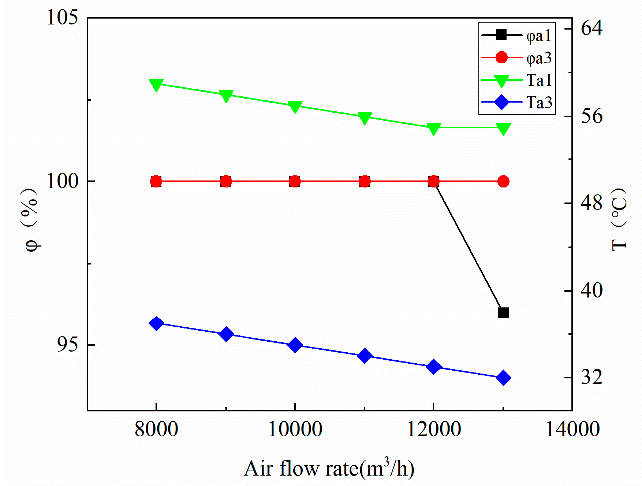
Figure 7. E ff ect of air flow rate on air humidity and air Figure 7. Effect of air flow rate on air humidity and air temperature. Figure 7. Effect of air flow rate on air humidity and air temperature.